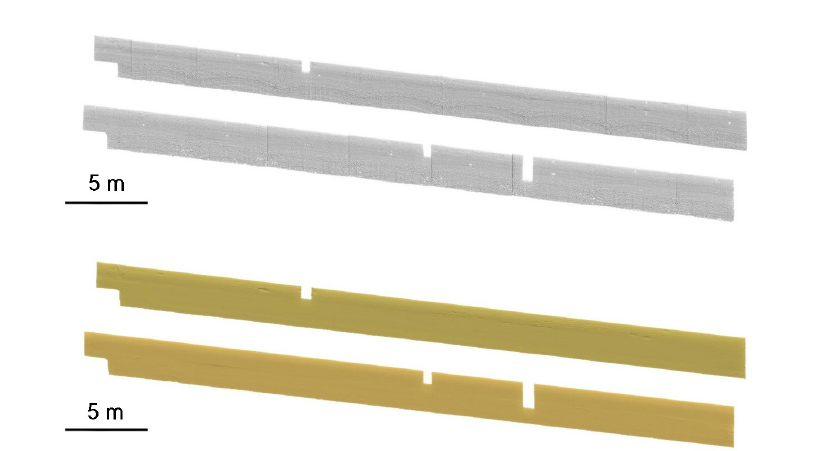
Figure 14. (top) Evaluated sonar point cloud and (bottom) laser reference